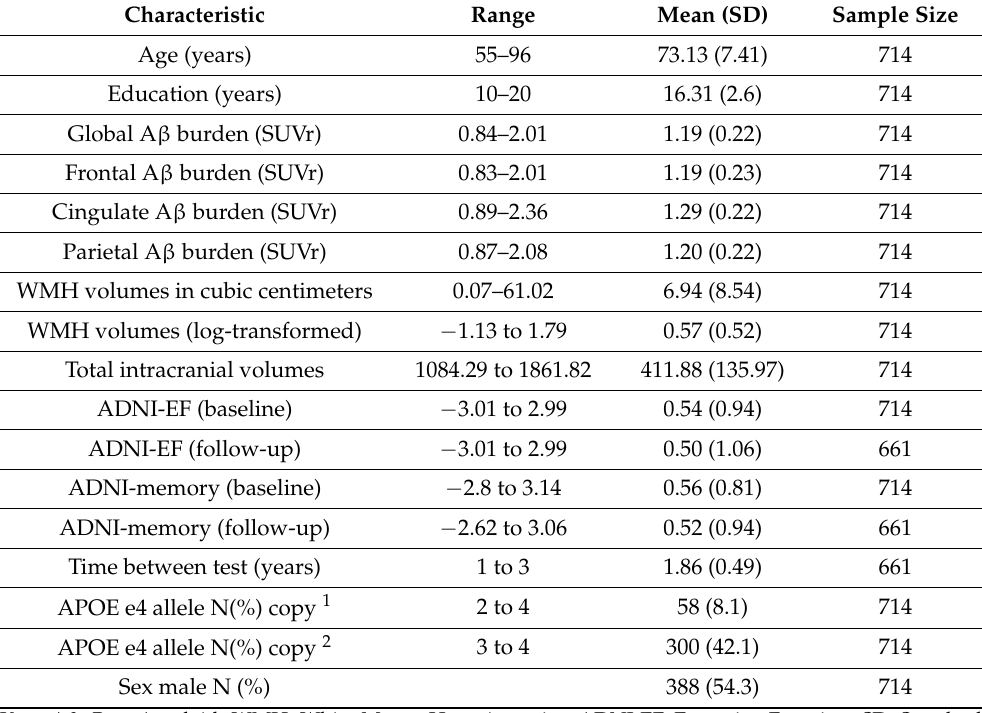
Table 1. Characteristics of